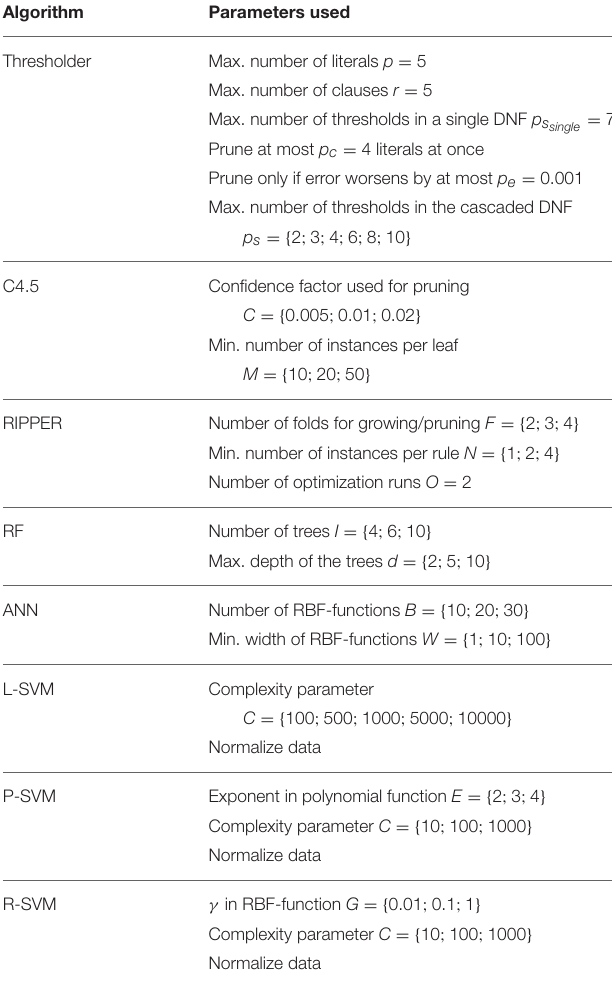
TABLE 3 | Parameter sets used for the learning algorithms.